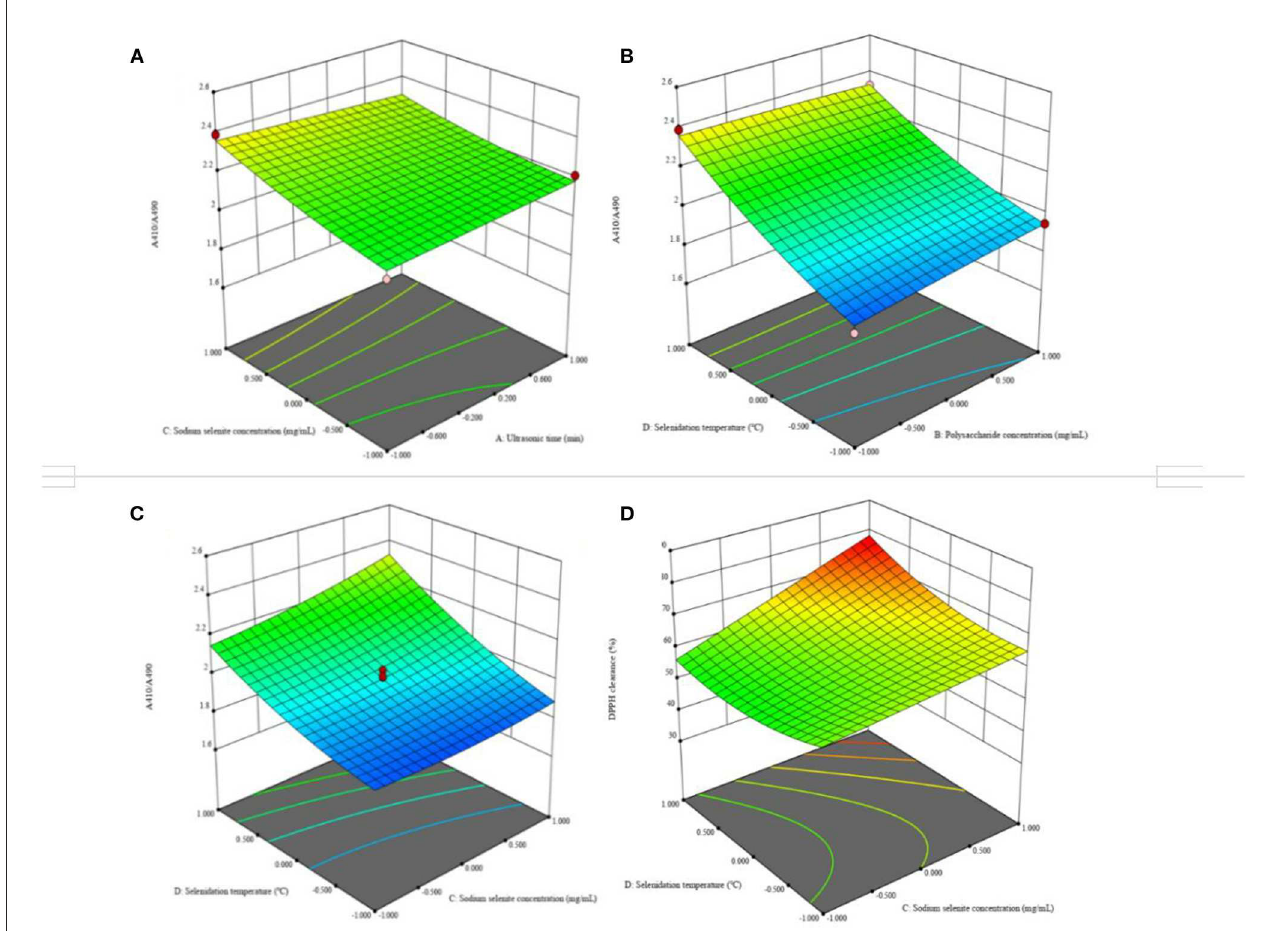
FIGURE12 Effects of response on extraction yield of selenized chestnut polysaccharides (A) ultrasonic time and sodium selenite concentration (B) polysaccharide concentration and selenite temperature (C) sodium selenite concentration and selenite temperature (D) sodium selenite concentration and selenite